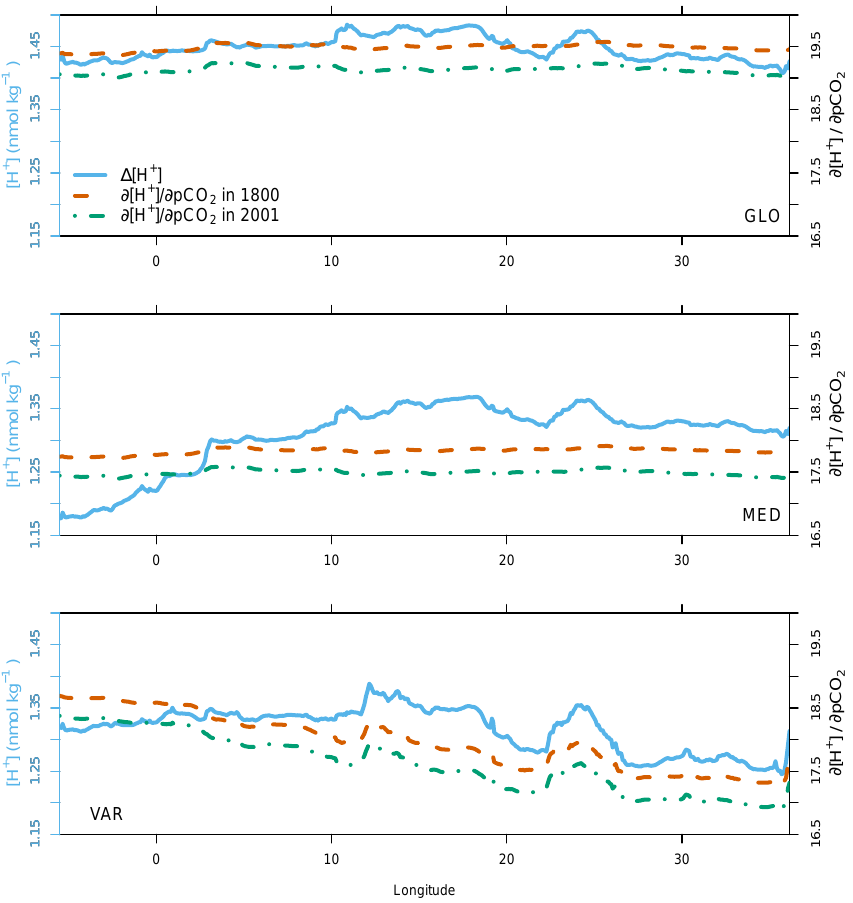
Figure 16. Meridional mean of the simulated surface acidification rate ∂ [H + ] /∂p CO 2 (pmolkg − 1 µatm − 1 ) in 1800 (dashed orange line) and in 2001 (dashed-dotted green line) across the Mediterranean Sea. Also shown is the corresponding simulated [H + ] change between 1800 and 2001 in nmolkg − 1 (solid light-blue line). Meridional means are computed using grid cells with salinities above 32 to avoid biases near river